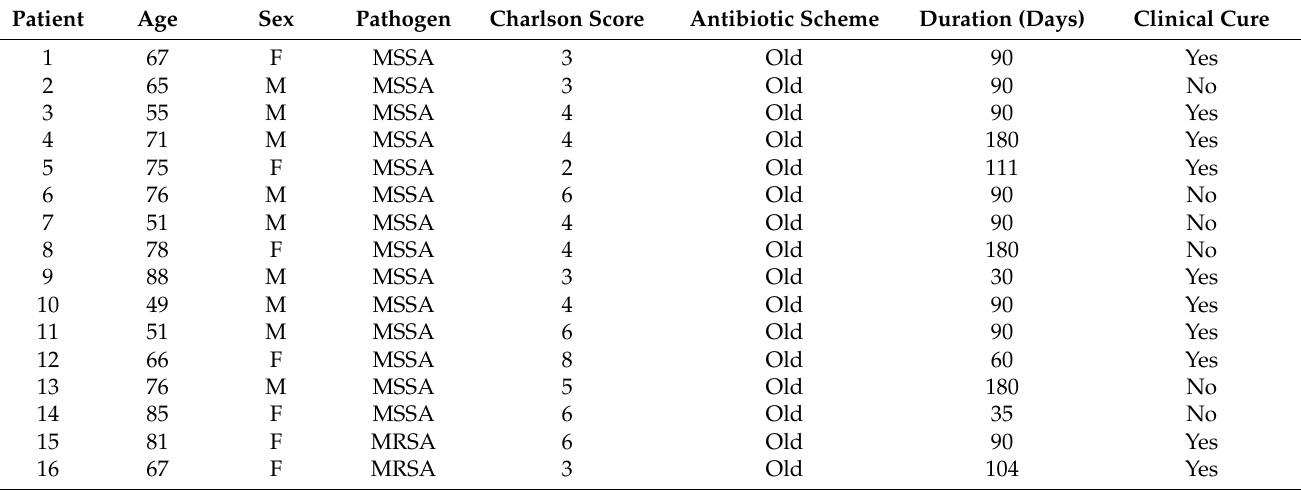
Table 2. Treatment data from